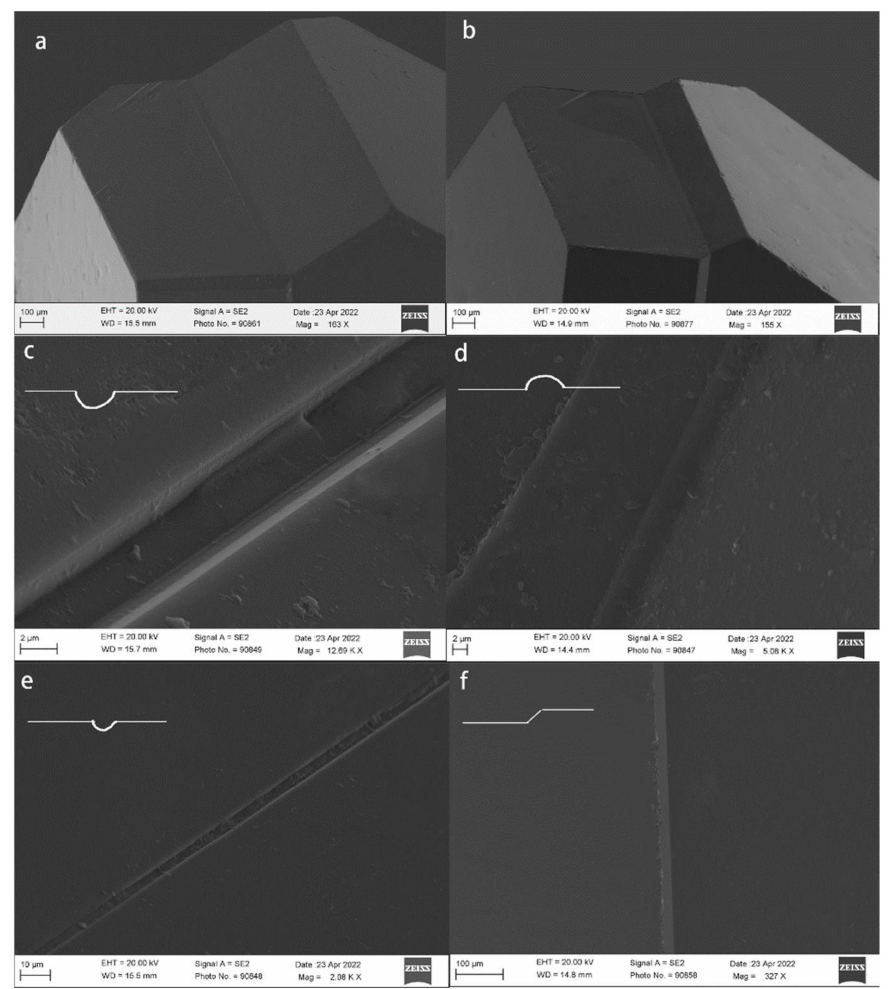
Figure 4. The morphology features of the twin boundary observed by SEM, which indicates the twin boundary is not a sharp straight line but a variety of morphological features: ( a – e ) the morphology features of the twin boundary are similar to the shape of the pipe with a different height to the crystal plane in TW-01 and TW-07; ( f ) the twin boundary forms a zigzag structure in